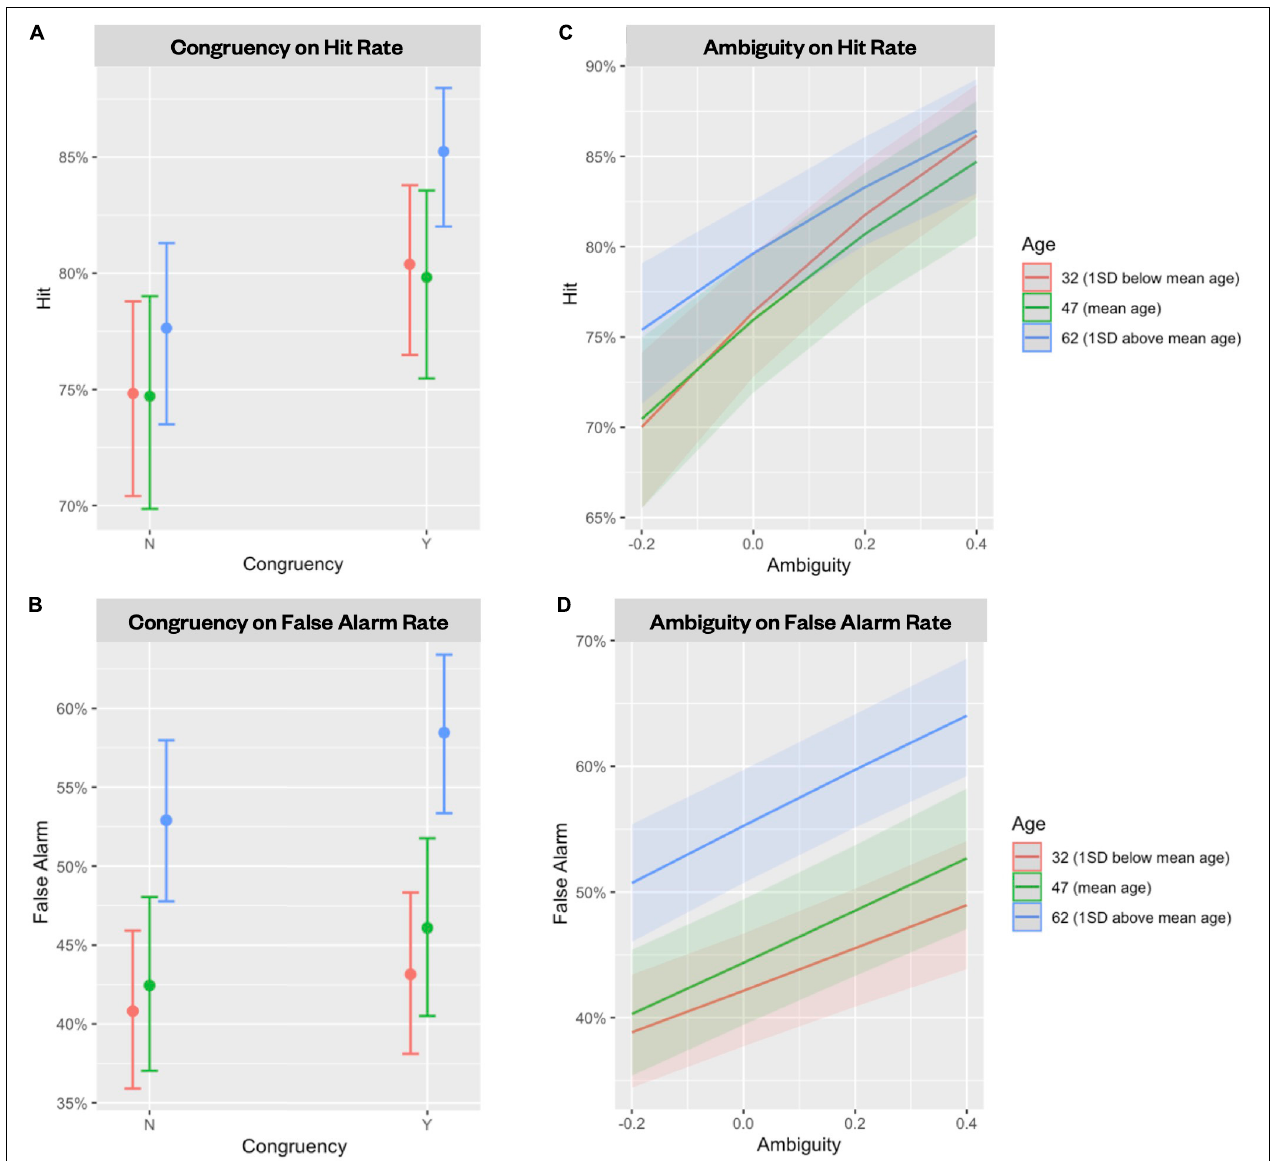
FIGURE 4 | Effect of congruency and ambiguity on memory hit rate and false alarm rate. Congruent pairs were related to a higher hit rate ( p < 0.001) particularly in people over 31 years (A) , as well as a higher false alarm rate ( p < 0.001) in people over 45 years ( p = 0.043). (B) More ambiguous pairs were related to a higher hit rate ( p < 0.001) (C) and a higher false alarm rate ( p < 0.001) (D) across all ages. Error bars and shaded areas represent 95% confidence